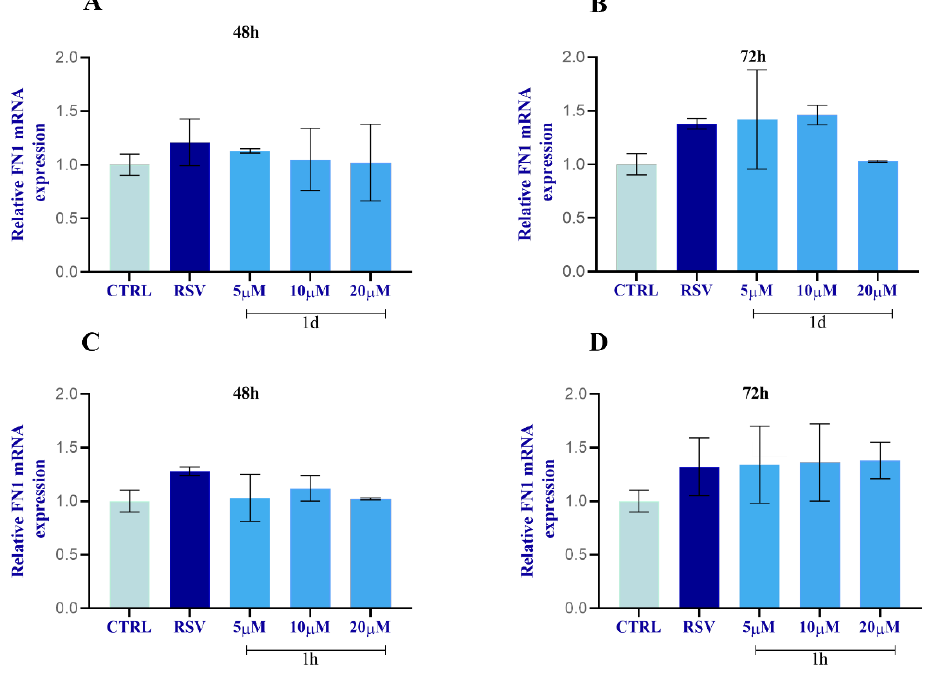
Figure 15. Effects of 1d ( A , B ) and 1h ( C , D ) on FN1 expression at 48 h and 72 h. The histograms represent normalized data for the housekeeping GAPDH. The values represent the average of three independent experiments with the relative SD (error bars).